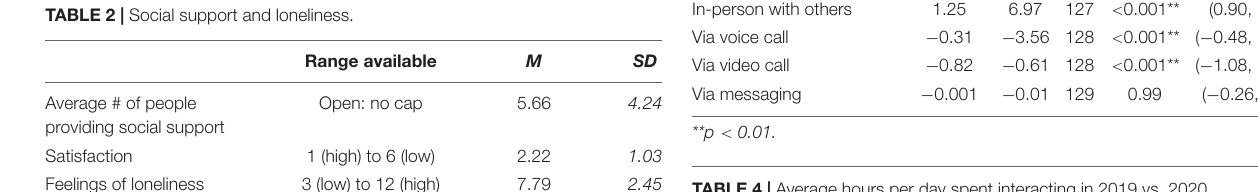
TABLE 4 | Average hours per day spent interacting in 2019 vs.